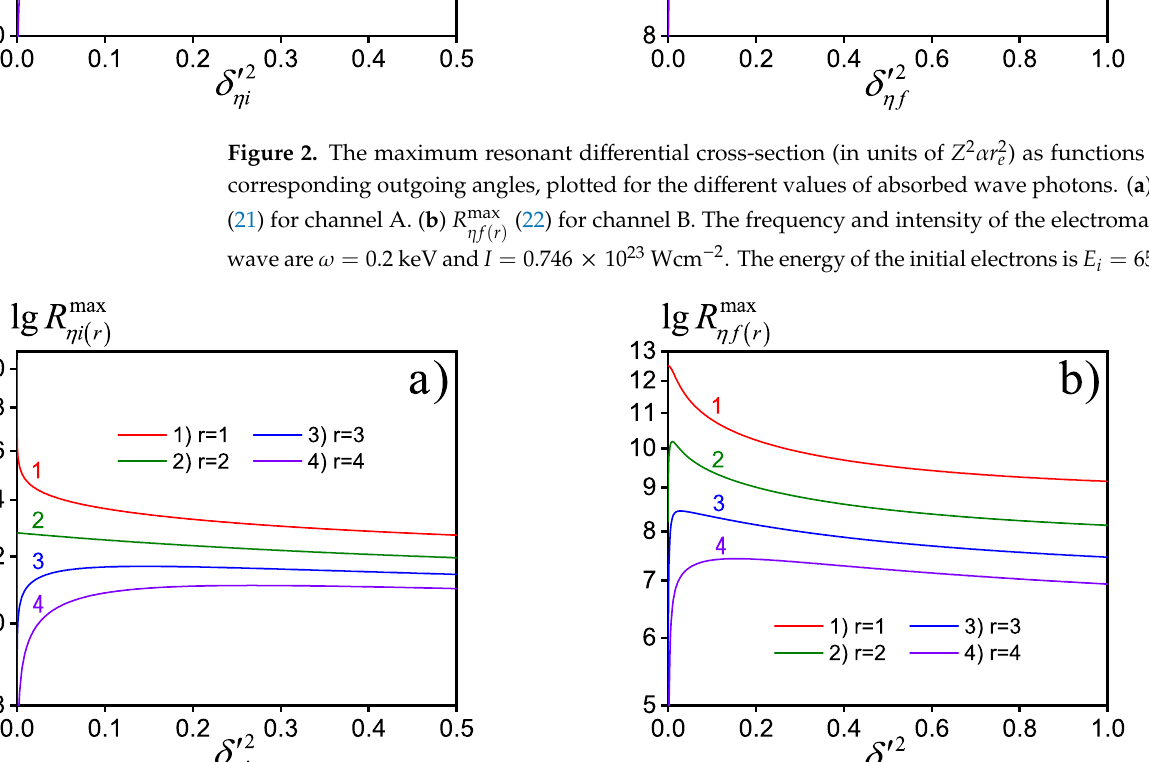
Figure 3. The maximum resonant di ff erential cross-section (in units of Z 2 α r 2 e ) as functions of the corresponding outgoing angles, plotted for the di ff erent values of absorbed wave photons. ( a ) R max η (21) for channel A. ( b ) R max η (22) for channel B. The frequency and intensity of the electromagnetic f ( r ) − 2 wave are ω = 20 keV and I = 0.746 × 10 27 Wcm . The energy of the initial electrons is E i = 65